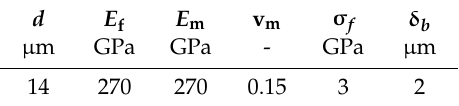
Table 3. Physical parameters used in fracture toughness calculation [21,22].